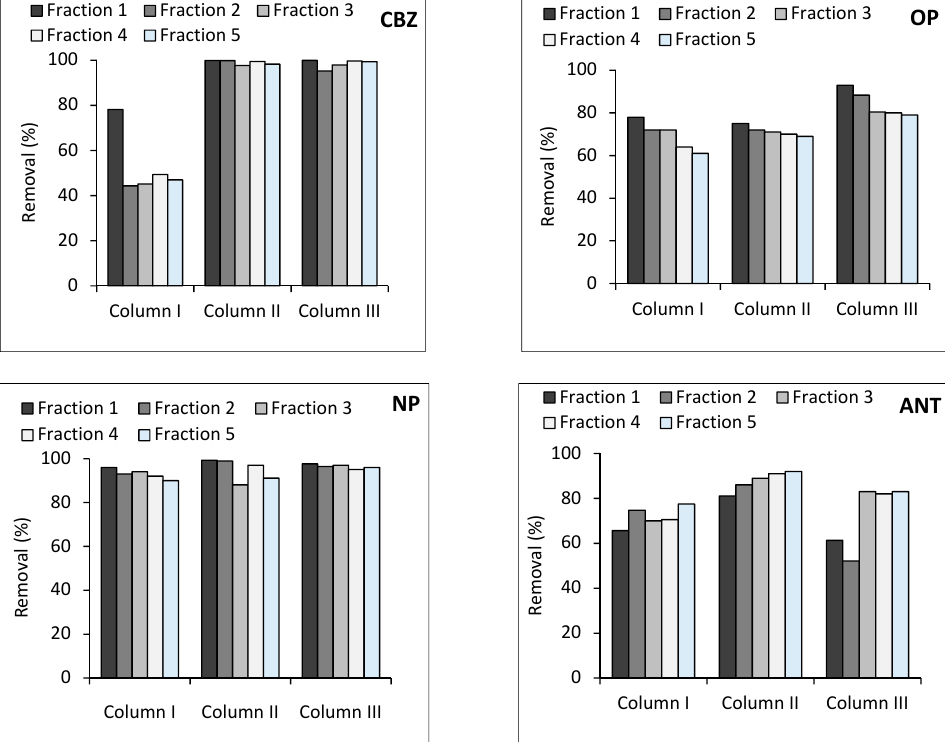
Figure 7. Micropollutants removal in fixed bed column in time.